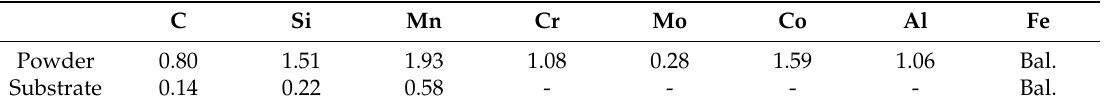
Table 1. Chemical composition of the powder and substrate